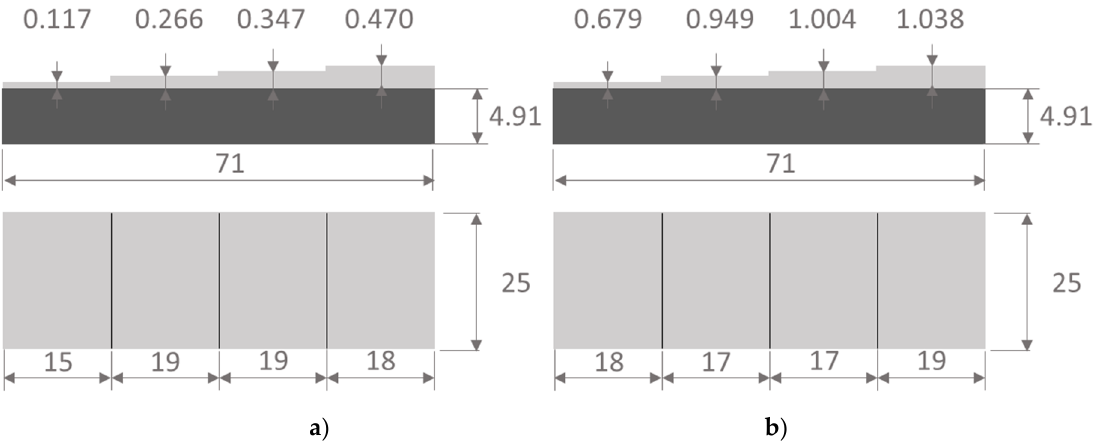
Figure 3. Scheme of sample 1 of coating thickness in the range 0.117–0.470 mm ( a ) and sample 2 of coating thickness in the range 0.679–1.038 mm ( b ).